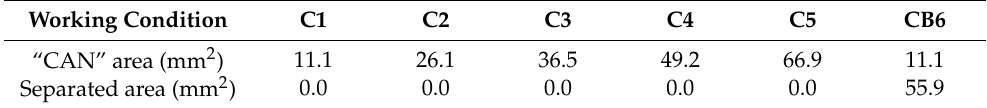
Table 1. Micro-crack settings of different